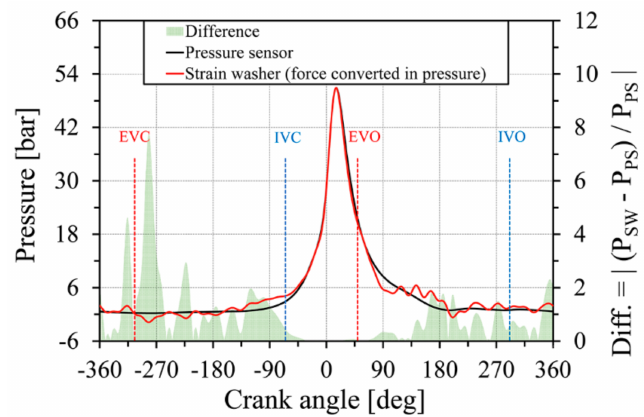
Figure 8. Strain washer signal vs. Pressure sensor signal at 4000 rpm and full